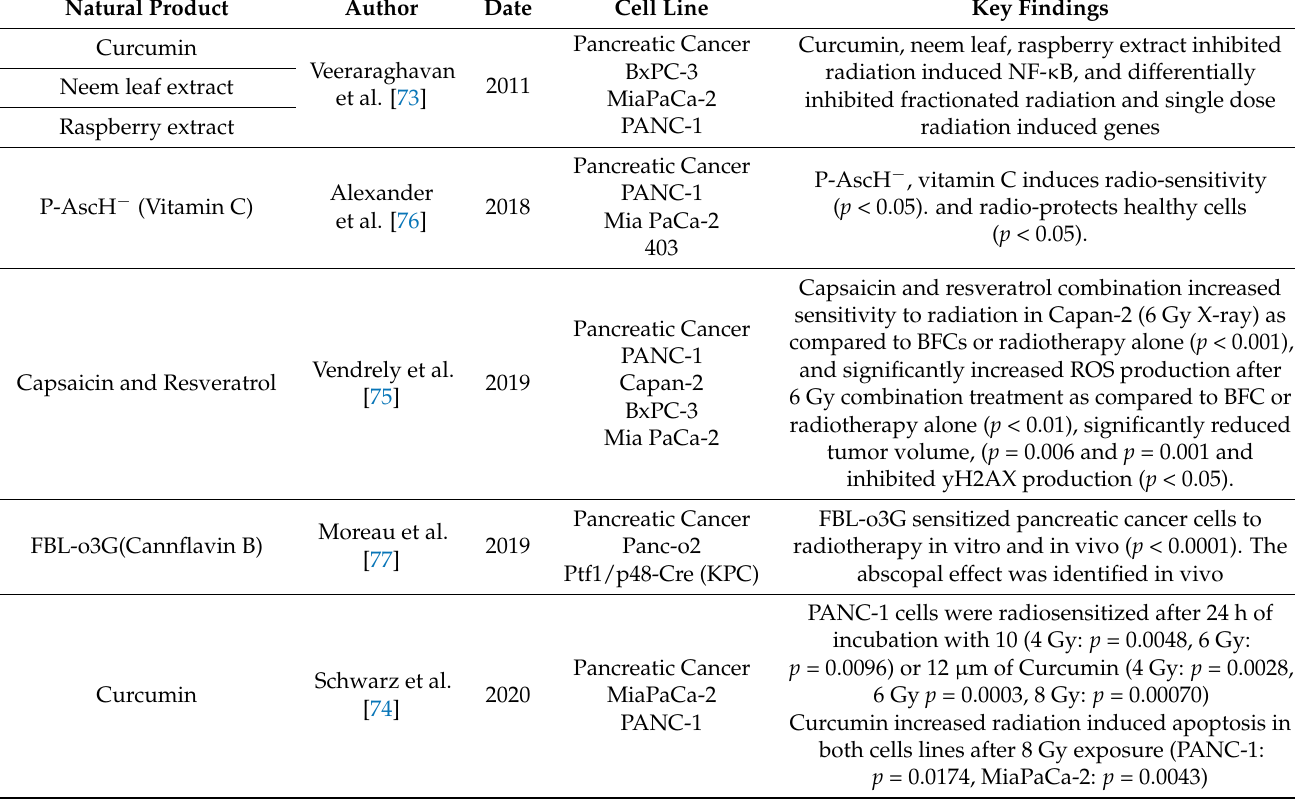
Table 3. Natural